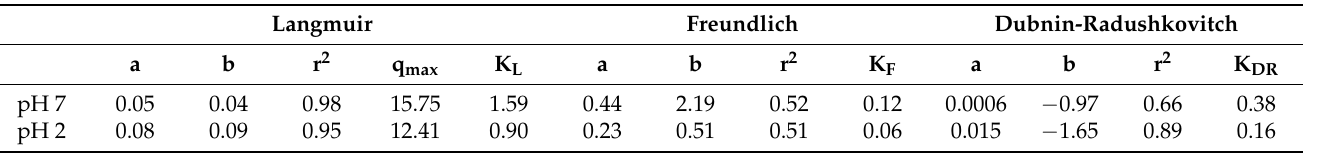
Table 2. Zn binding onto TERM adsorptions parameters (q max , K L,F,D-R ) at pH 2 and pH 7 deduced from Langmuir, Freundlich and Dubinin-Radushkovitch